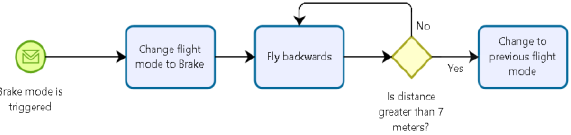
Figure 2. “Brake” mode flow chart.